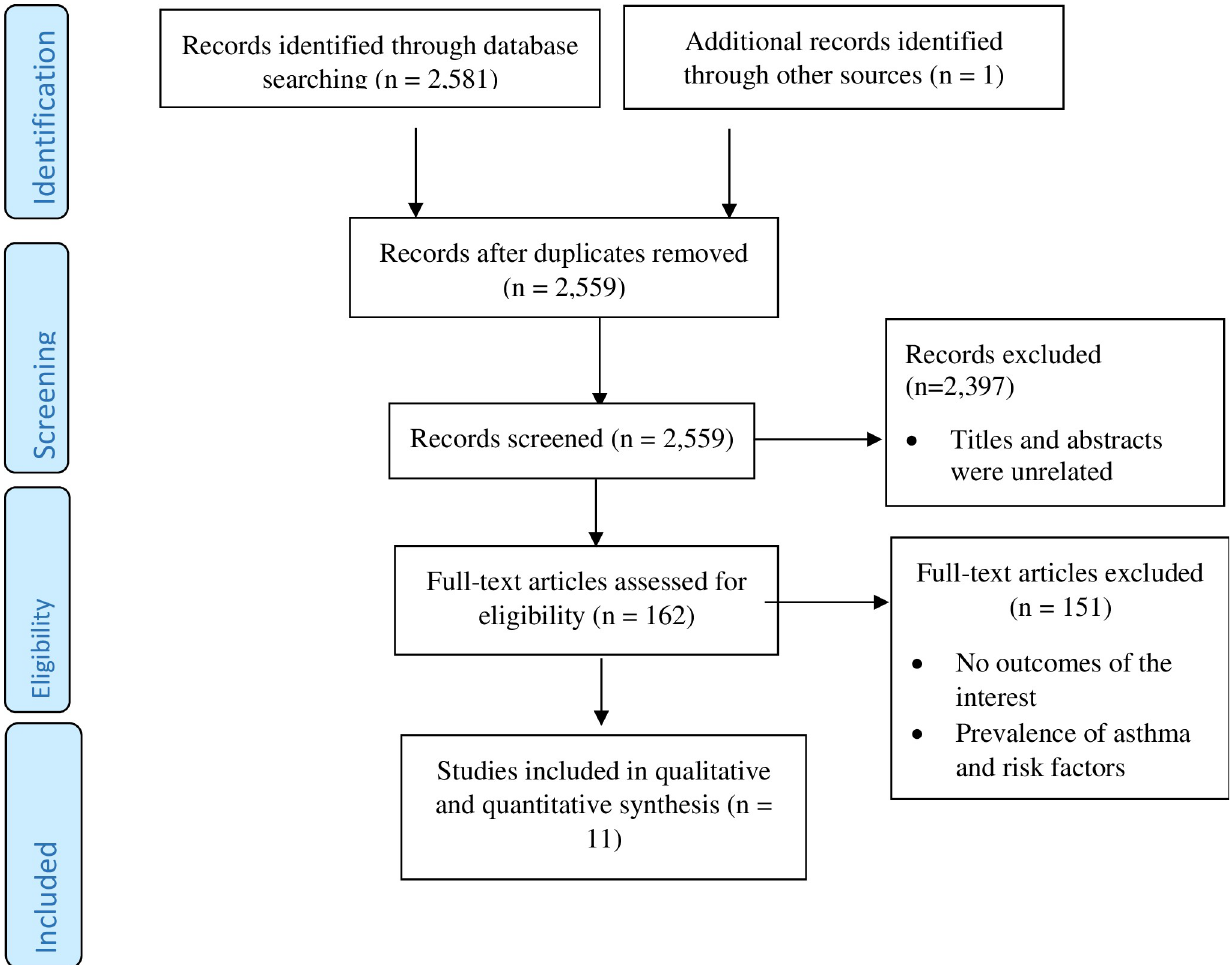
Fig 1. PRISMA flow diagram of the included